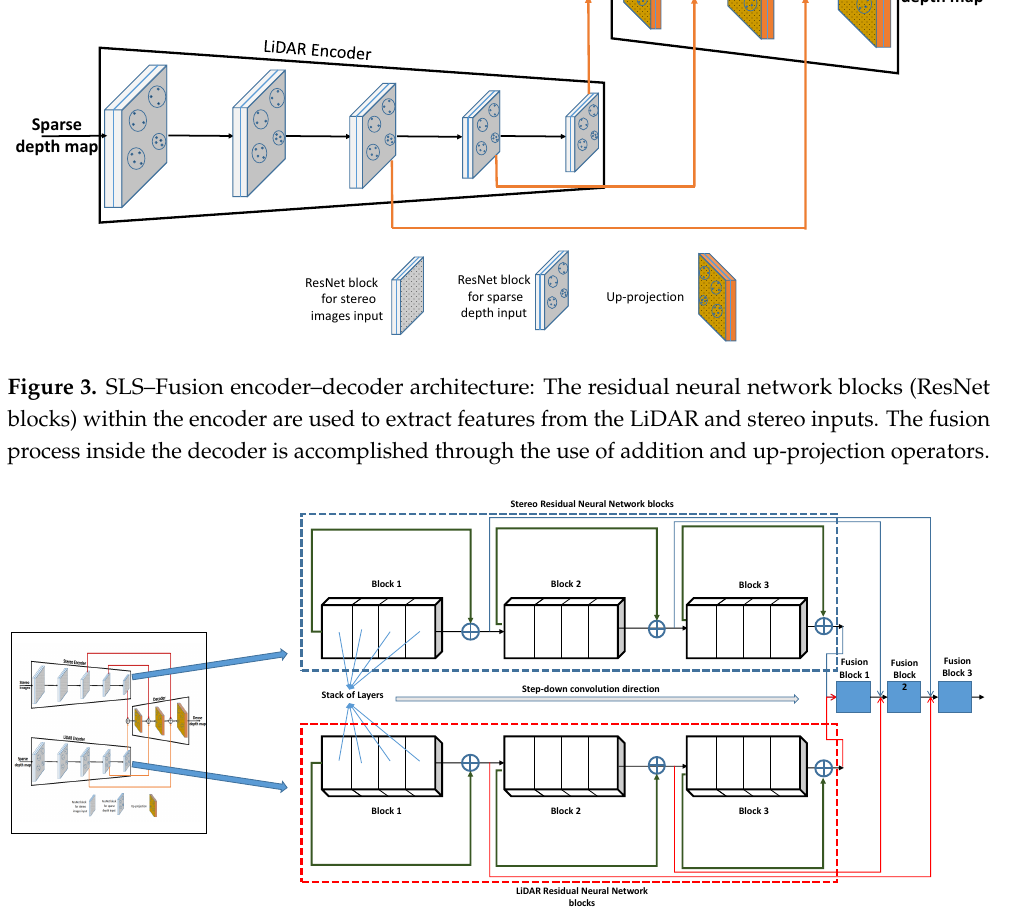
Figure 4. The structure of Stereo and LiDAR residual blocks inside the encoder/decoder of the SLS– Fusion model. A stack of layers is grouped into blocks for stereo and LiDAR networks, conducted by a step-down convolution direction and followed by a set of fusion